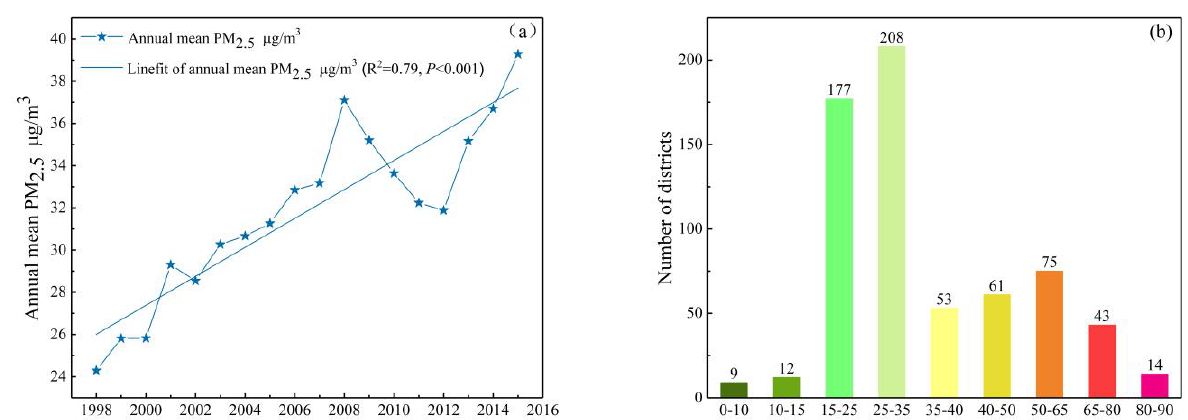
Figure 2. PM 2.5 annual mean change (a) and the number of districts different levels of annual mean PM 2.5